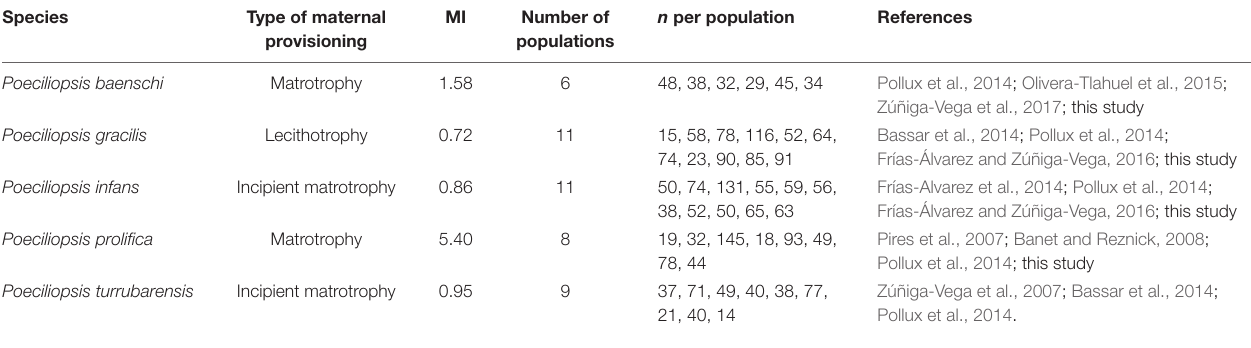
TABLE 1 | List of the five study species from the fish genus Poeciliopsis with information on the type of maternal provisioning to developing embryos (matrotrophy, incipient matrotrophy, or lecithotrophy), matrotrophy index (MI), number of populations per species, and sample size ( n = number of reproductive females) per population. Species Type of maternal MI provisioning